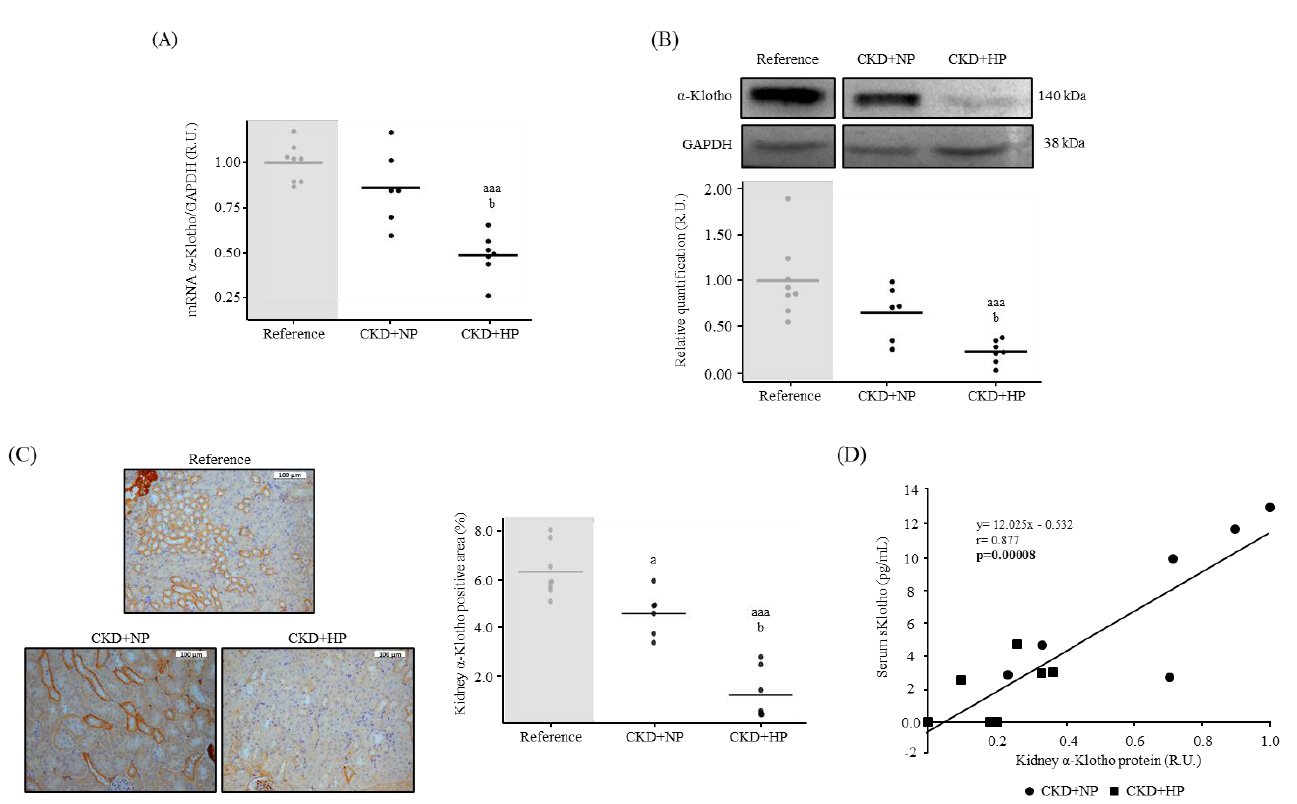
Figure 2. In vivo effects of chronic kidney disease (CKD) and dietary phosphorus intake on kidney α -Klotho expression and its correlation with sKlotho ( A ) Kidney α -Klotho mRNA levels from Sham- operated fed normal phosphorus (NP) (Reference) and CKD mice fed NP or high phosphorus (HP) diet for 14 weeks. All values are expressed relative to reference group. Mean and individual mice values are shown. aaa p < 0.005 vs. Reference, b p < 0.05 vs. CKD+NP. R.U., relative units vs. Reference. ( B ) Representative image of Western blot analysis and relative quantification. All values are expressed relative to the reference group. Horizontal lines depict mean values. aaa p < 0.005 vs. Reference, b p < 0.05 vs. CKD+NP. R.U.: Relative Units vs. reference group. ( C ) Representative images of kidney α-Klotho and its quantification. Each inset indicates the relative scale in µm. a p < 0.05 vs. Reference, aaa p < 0.005 vs. Reference, b p < 0.05 vs. CKD+NP. ( D ) Correlation between kidney α -Klotho protein expression and soluble Klotho (sKlotho) levels within CKD groups. Each shape represents, CKD+NP (●) and CKD+HP ( ■ ) values. GAPDH was used as housekeeping gene or loading